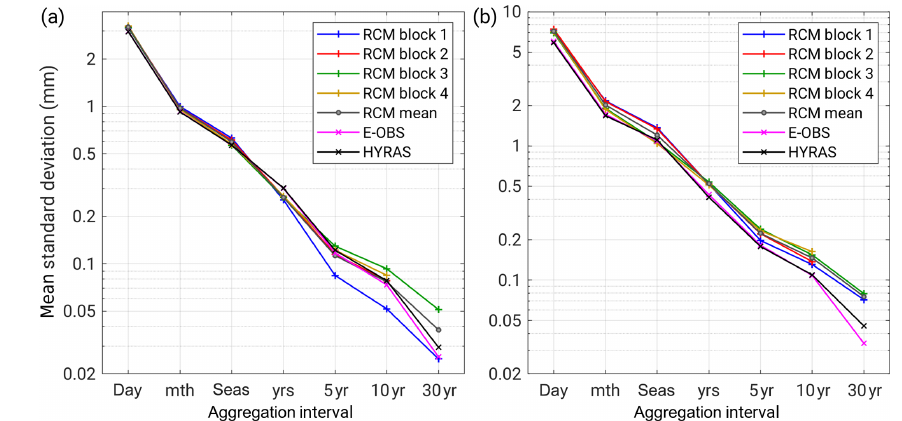
Figure 3. Mean standard deviation σ (cid:48) in mm (mean over data blocks) of spatially averaged precipitation aggregated over different time intervals: daily (day), monthly (month), seasonal (seas), yearly (years), and 5-/10-/30-year running mean (5yr/10yr/30yr) for (a) ME ∗ and (b) AL ∗ (TP1b; 1951–2006). The four data blocks of LAERTES-EU are considered separately; RCM mean stands for the complete ensemble mean (gray). The results for E-OBS and HYRAS are given in black and magenta. Note that it is not possible to estimate the 30-year values for the decadals of data blocks 2 and 4.